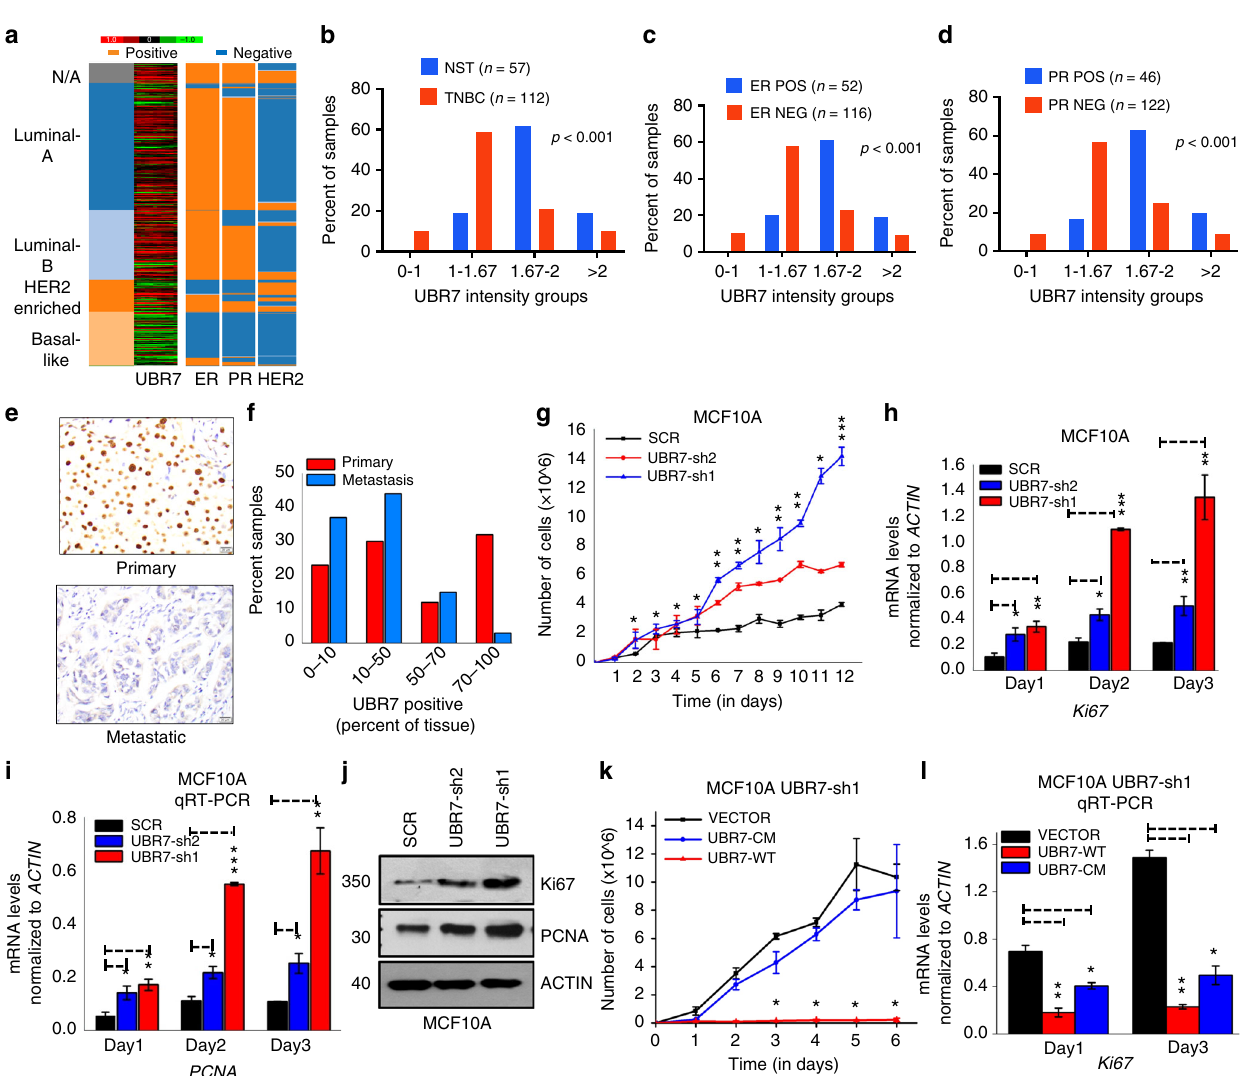
Fig. 3 UBR7 inhibits breast cancer cell proliferation. a Heatmap showing that UBR7 expression is downregulated in triple-negative or basal-type breast cancer (analysis of data from TCGA database). Green and red indicates down- and up-regulated, respectively. b – d Immunohistochemical analysis representing low UBR7 expression analyzed in triple-negative ( b ), estrogen receptor (ER)-negative ( c ), and progesterone receptor (PR)-negative ( d ) breast tumors. e , f Representative images of primary and metastatic invasive breast carcinoma showing UBR7 expression as analyzed immunohistochemically. Scale bar indicates 20 µ m. g Proliferation of MCF10A cells expressing scrambled (SCR) or UBR7 (UBR7-sh1/UBR7-sh2) short hairpin RNAs (shRNAs). h , i Quantitative real-time PCR (qRT-PCR) analysis of Ki-67 ( h ) and PCNA ( i ) from cultured MCF10A cells expressing SCR or UBR7 (UBR7-sh1/UBR7-sh2) shRNAs in a time-dependent manner. j Immunoblots of MCF10A cells expressing SCR or UBR7-shRNAs to monitor expression of Ki-67 and PCNA. ACTIN was used as a loading control. k Proliferation of cultured MCF10A UBR7-sh1 cells expressing a vector (VECTOR), WT (UBR7-WT), or catalytic-mutant (UBR7-CM). l qRT-PCR analysis of Ki-67 in MCF10A UBR7-sh1 cells expressing vector (VECTOR), wild-type (UBR7-WT), or CM (UBR7-CM) in a time- dependent manner. In all panels, error bars indicate standard deviation (s.d.); n = 3 technical replicates of a representative experiment (out of three experiments). P values were calculated using two-tailed t tests. * P < 0.05; ** P < 0.001; *** P <